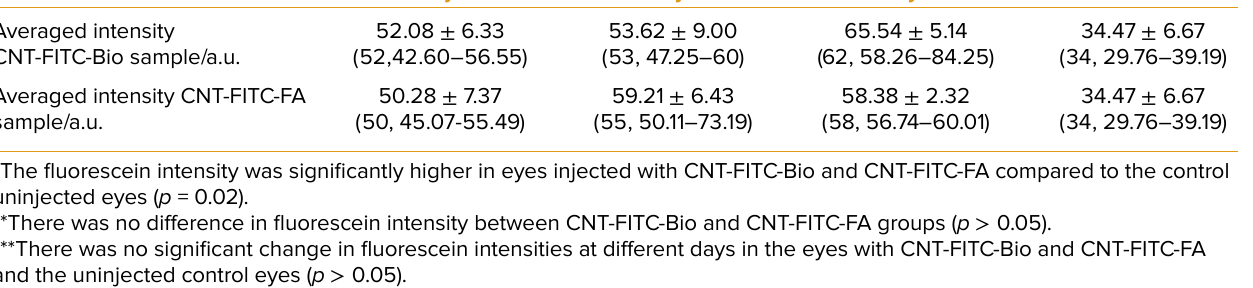
Table 1. Averaged intensities measured in eyes injected with CNT-FITC-Bio and CNT-FITC-FA Day1 Day2 Day3 Control Averaged intensity CNT-FITC-Bio sample/a.u. Averaged intensity CNT-FITC-FA